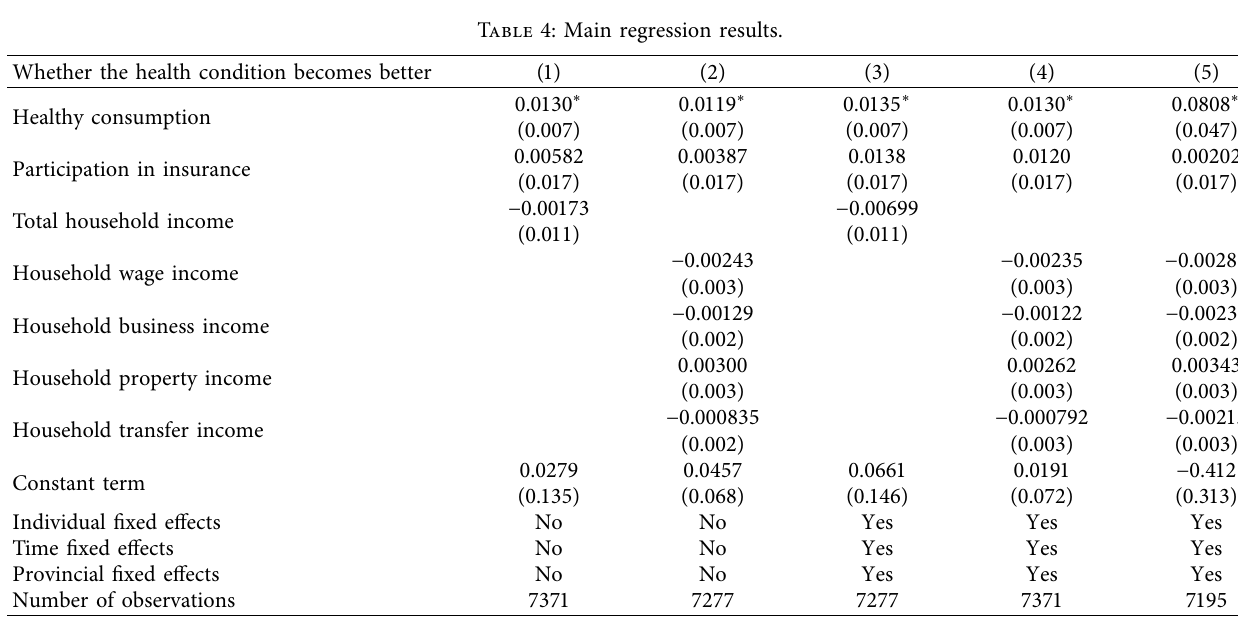
Table 4: Main regression results.